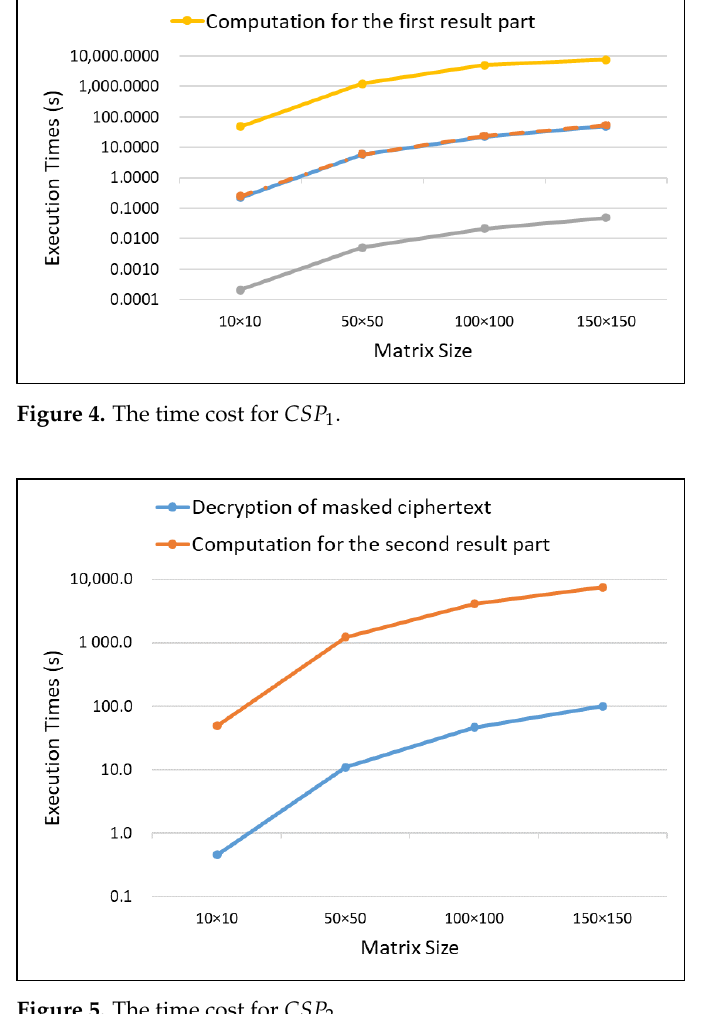
Figure 5. The time cost for CSP 2